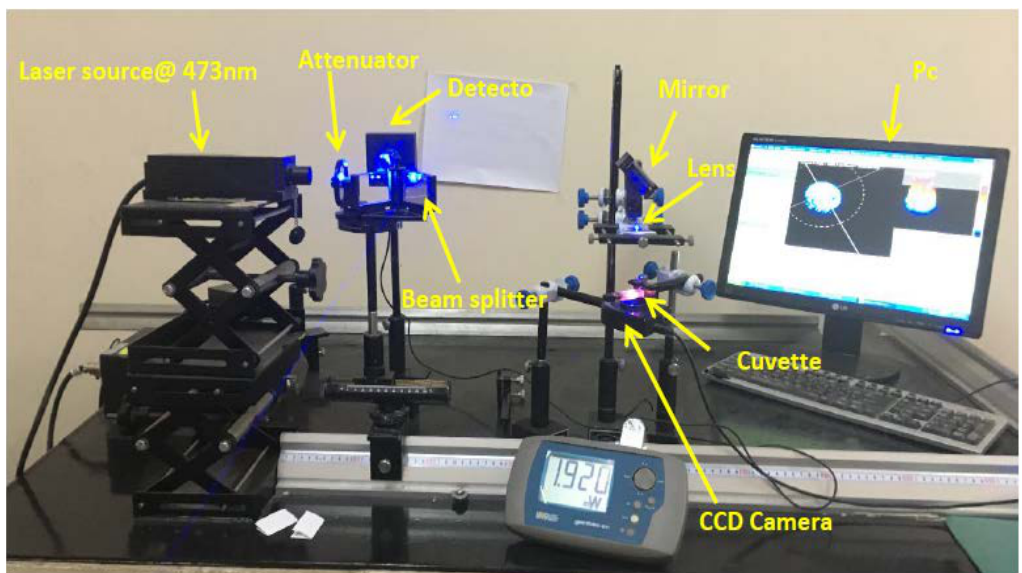
Fig.1: Graphical diagram of the experimental set ــ up.